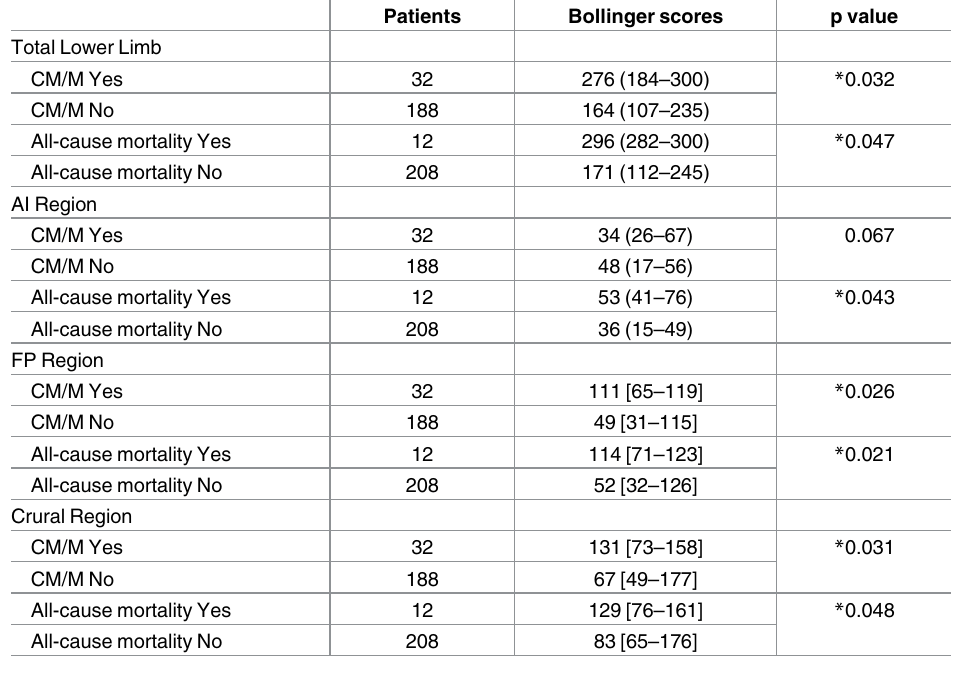
Table 5. Total and segmental Bollinger scores in patients with and without cardiovascular events dur- ing